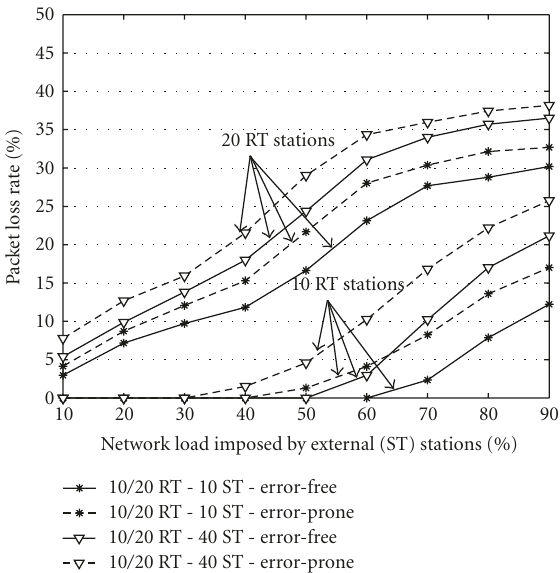
Figure 5: Packet loss rate (small and large pop.): error-free versus error-prone—MSP =